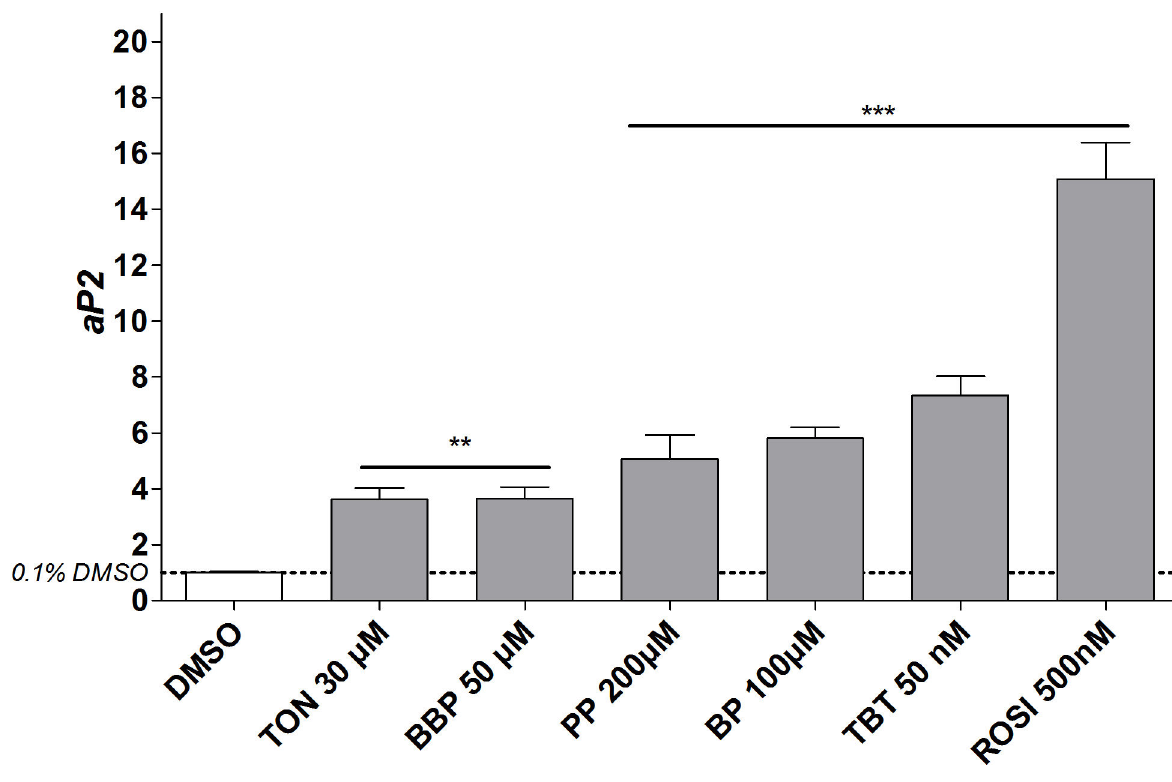
Figure 5. Gene expression of the adipocyte specific gene adipocyte specific protein 2 ( aP2 ) measured by Real-time PCR at day 10. Data are represented as the mean fold change relative to the solvent control of 3 biological replicates (mean±stdev; n = 3). Significant differences between the conditions were analysed with One Way ANOVA (Dunnet’s post hoc test; *p≤0.05; **p≤0.01;